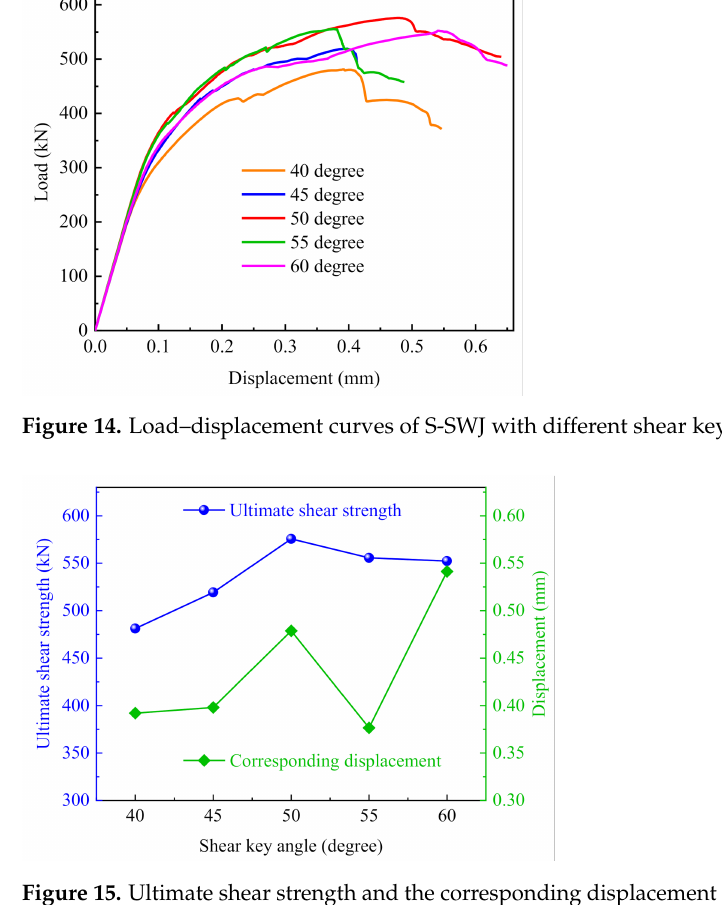
Figure 15. Ultimate shear strength and the corresponding displacement of S-SWJ with different shear key